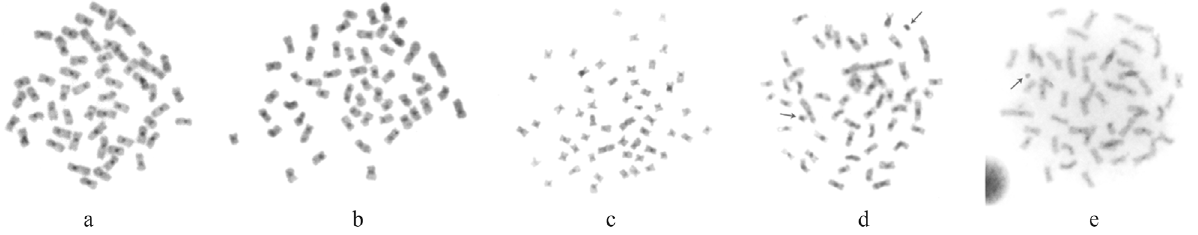
Figure 4 - C-banded cells of: (a) P. argenteus ; (b) P. brevis ; (c) P. costatus ; (d) P. lineatus and (e) P. nigricans. In P. lineatus , constitutive heterochromatin was only present in the centromeric regions of all A chromosomes. All supernumerary chromosomes were heterochromatic